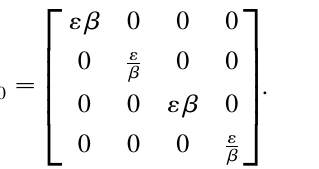
FIG. 1. Layout of the EMTEX